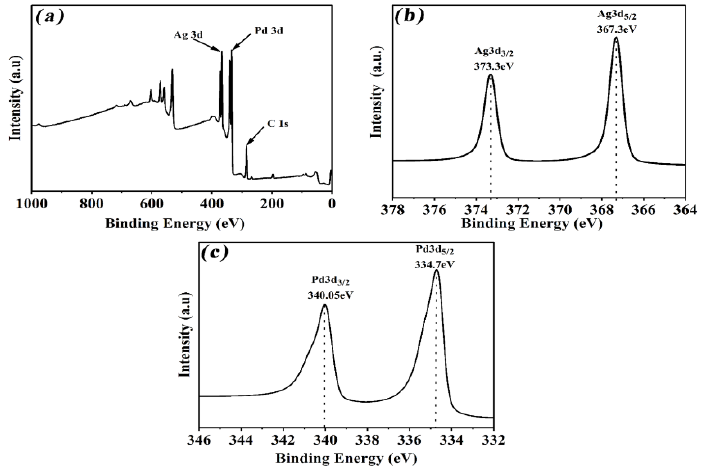
Figure 2. ( a ) Full XPS pattern of PdAg alloys; ( b ) high-resolution XPS spectra of Ag 3d; ( c ) high- resolution XPS spectra of Pd